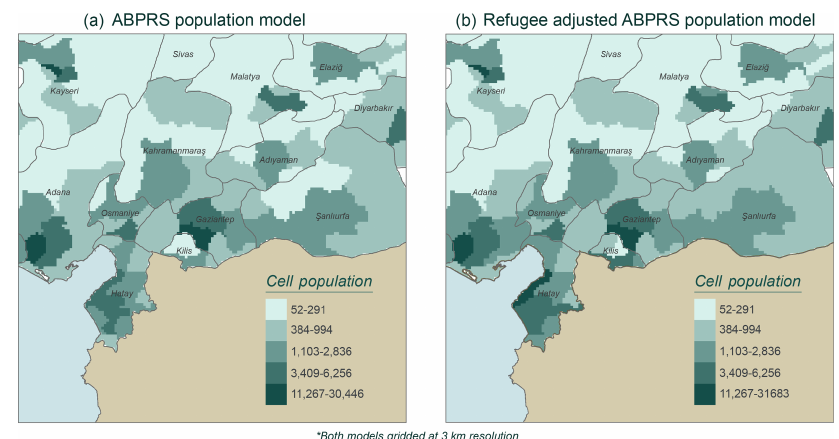
Figure 4. Gridded cellular population models produced from Turkish ABPRS data before (a) and after (b) including refugee statistics.